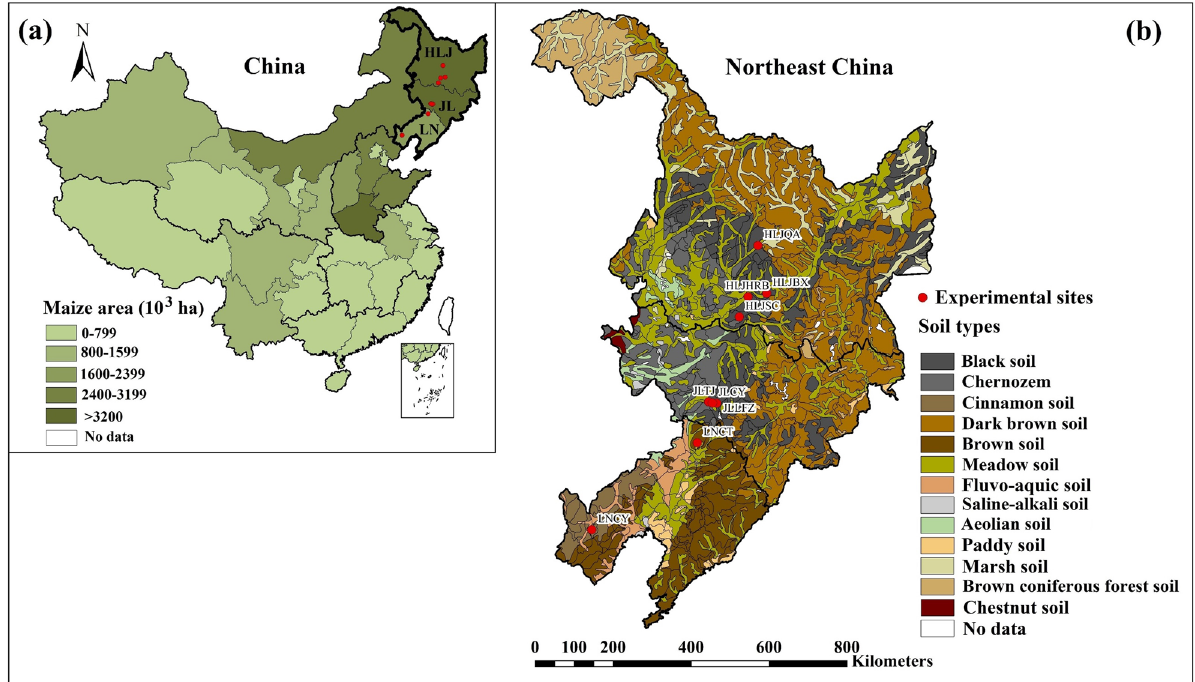
Figure 5. Field experimental sites for maize from 2011 to 2016 at Liaoning (LN), Jilin (JL) and Heilongjiang (HLJ) provinces in Northeast China. The map was created using ArcGIS software 10.4.1 (Environmental Systems Research Institute Inc., Redlands, USA). The area of maize ( a ) was obtained from the National Bureau of Statistics of China (http://data.stats .gov.cn) and soil type information ( b ) was available from the Soil Science Database